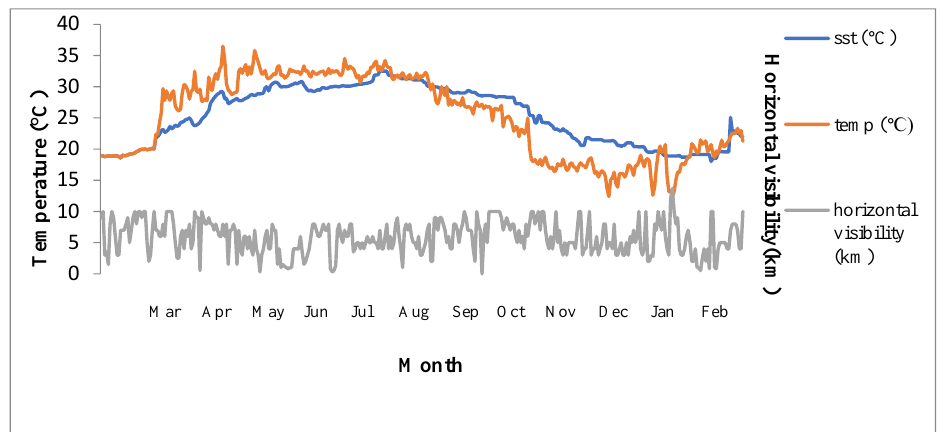
Figure 2. Time series of sea surface temperature, air temperature and horizontal vision in 2008 (sst: Sea surface temperature, temp: Air temperature).